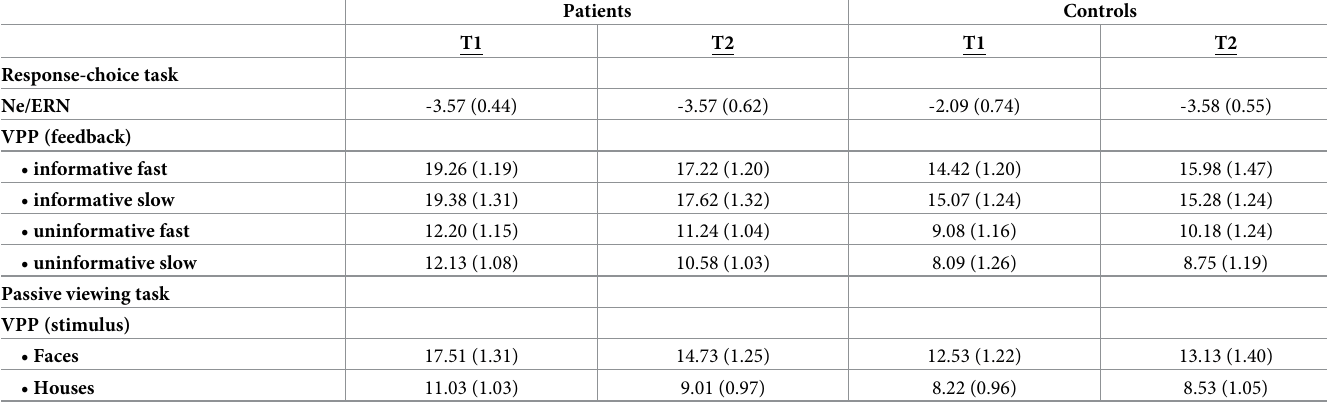
Table 3. Electrophysiological results of internal signal processing (Ne/ERN amplitude) and external signal processing (VPP peak-to-peak value) in the response- choice task and the passive viewing task. Patients